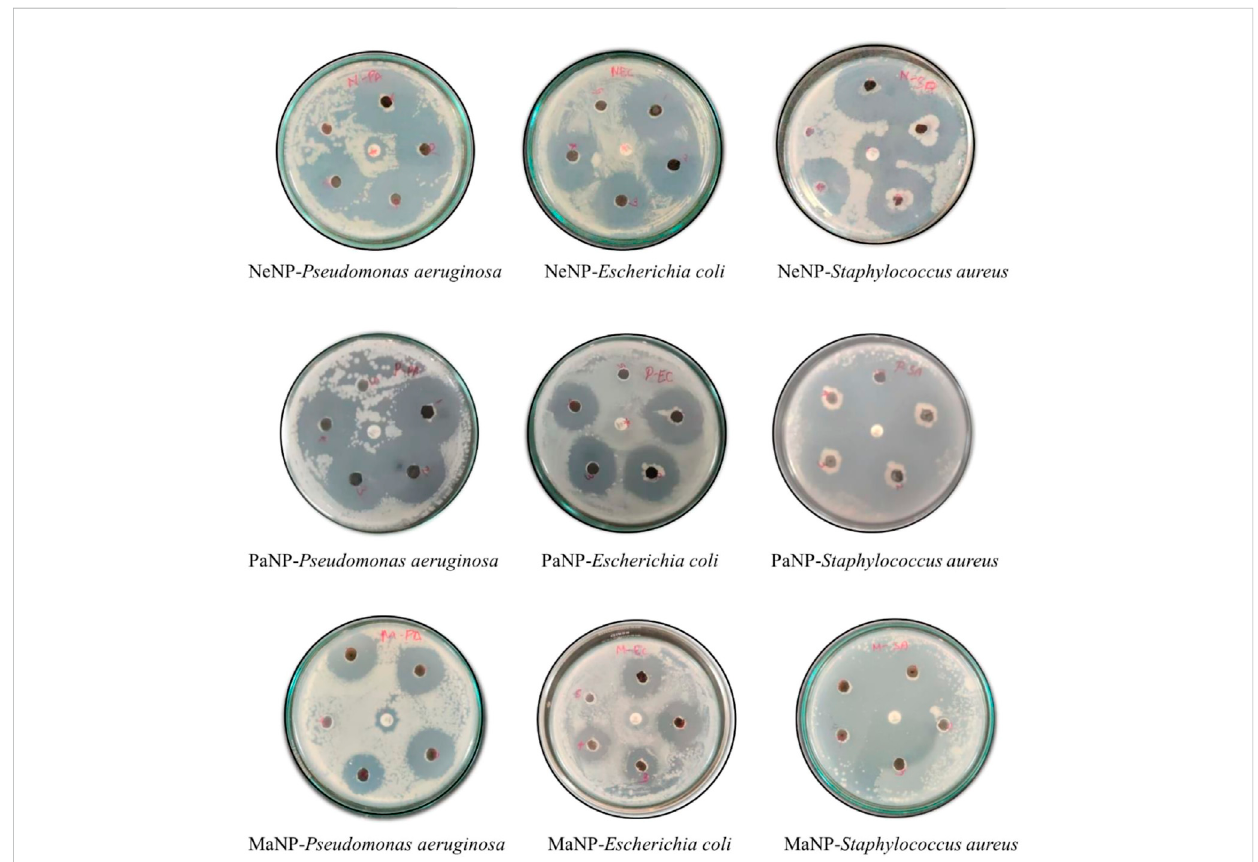
FIGURE 12 Zone of inhibition of three microorganisms by the naturally synthesized NPs from neem, papaya, and mango which are named NeNP, PaNP, and MaNP, respectively. Dilutionused 1 – 200 mg/mL; 2 – 100 mg/mL; 3 – 50 mg/mL; 4 – 25 mg/mL;5-negative control (autoclaved distilled water) and center amoxicillin -positive